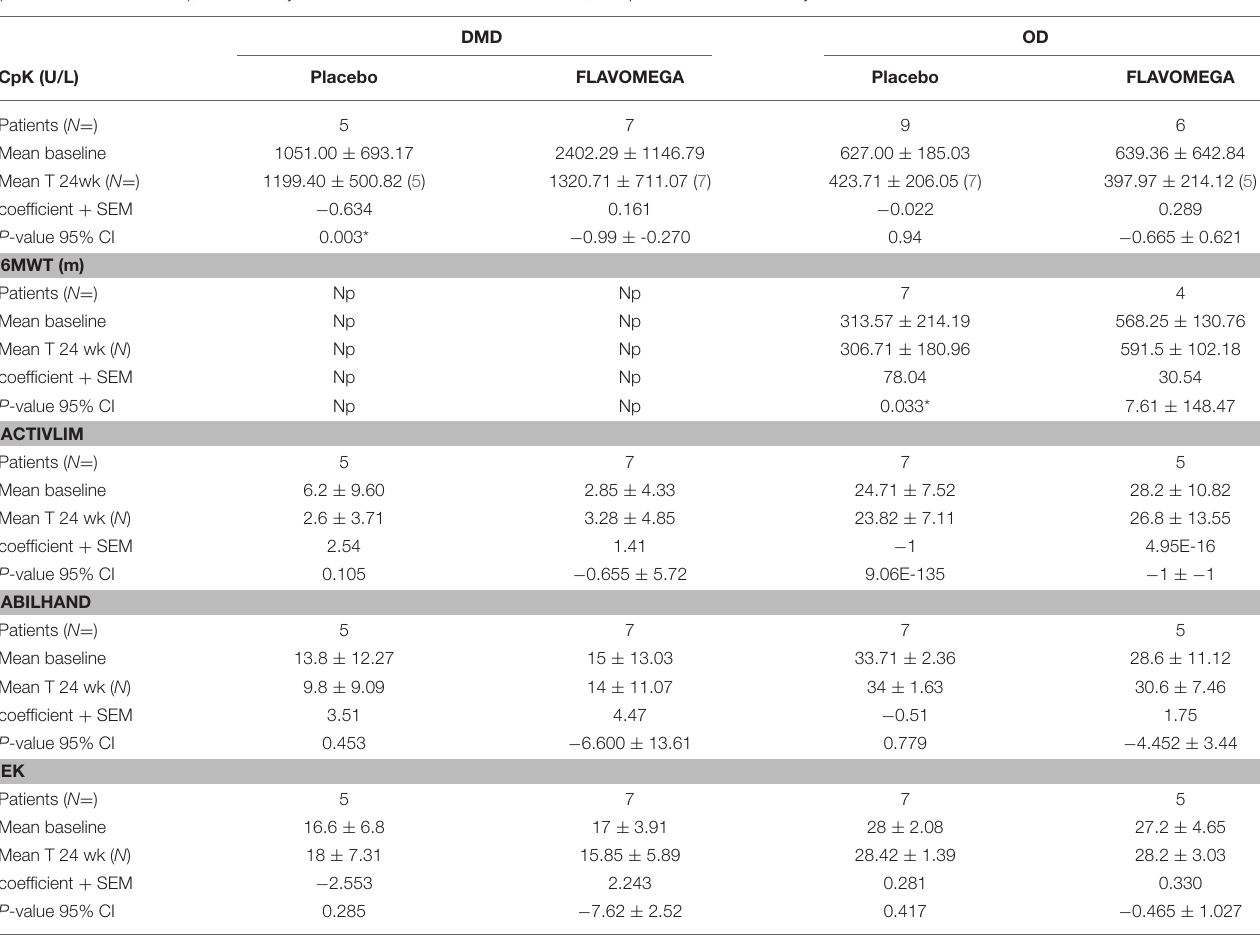
TABLE 11 | Linear regression of repeated measure (MMRM) analysis of secondary endpoints: Cpk analysis of absolute variation in serum levels (T24wk-baseline/baseline), 6MWT analysis of 1 T24wk-baseline meters walked, and performance scale analysis of 1 T24wk-baseline